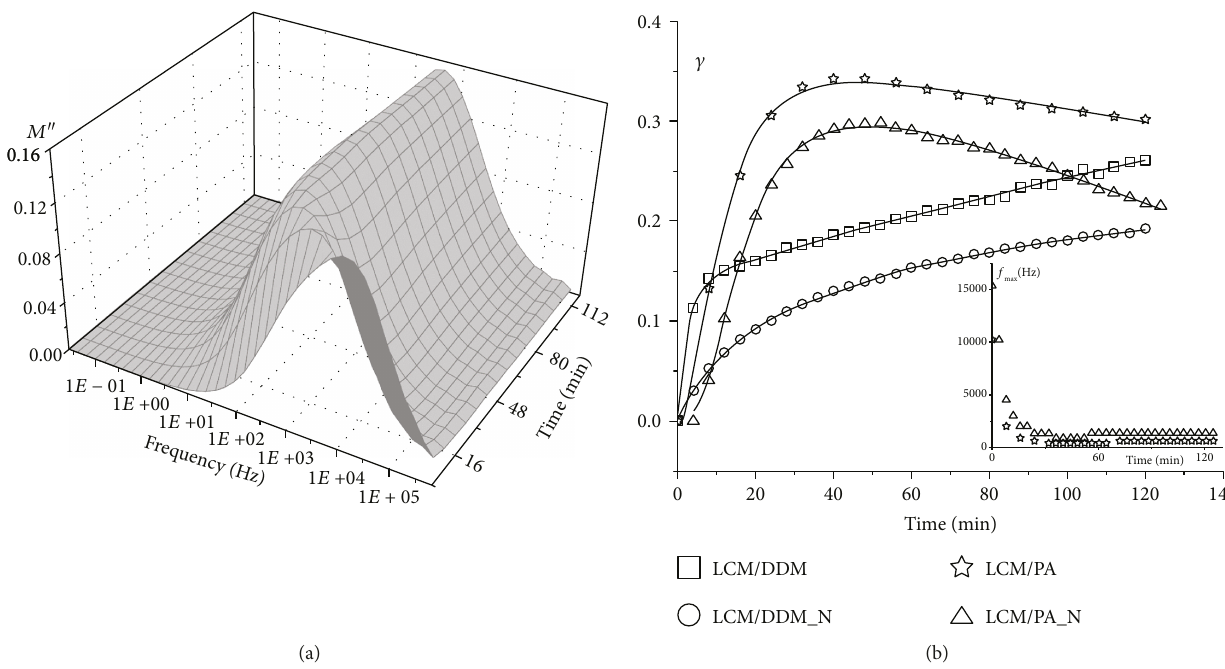
Figure 3: Curing process of the epoxy resin and its composites: (a) 3D representation (electric modulus versus frequency and time) of curing of the epoxy resin with pimelic acid and nanorods; (b) normalized real part of permittivity ( γ ) versus time for all the investigated mixtures, with solid lines representing the best fi t of the chosen kinetic model to the data (inset: estimated frequency of the M ″ peak versus time for composites cured with pimelic